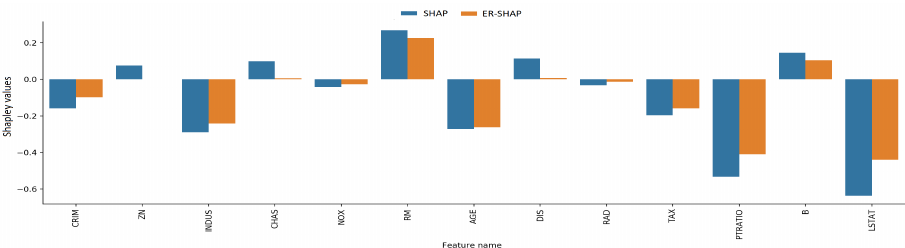
Figure 18. Shapley values obtained by means of SHAP and ER-SHAP for the Boston Housing dataset.